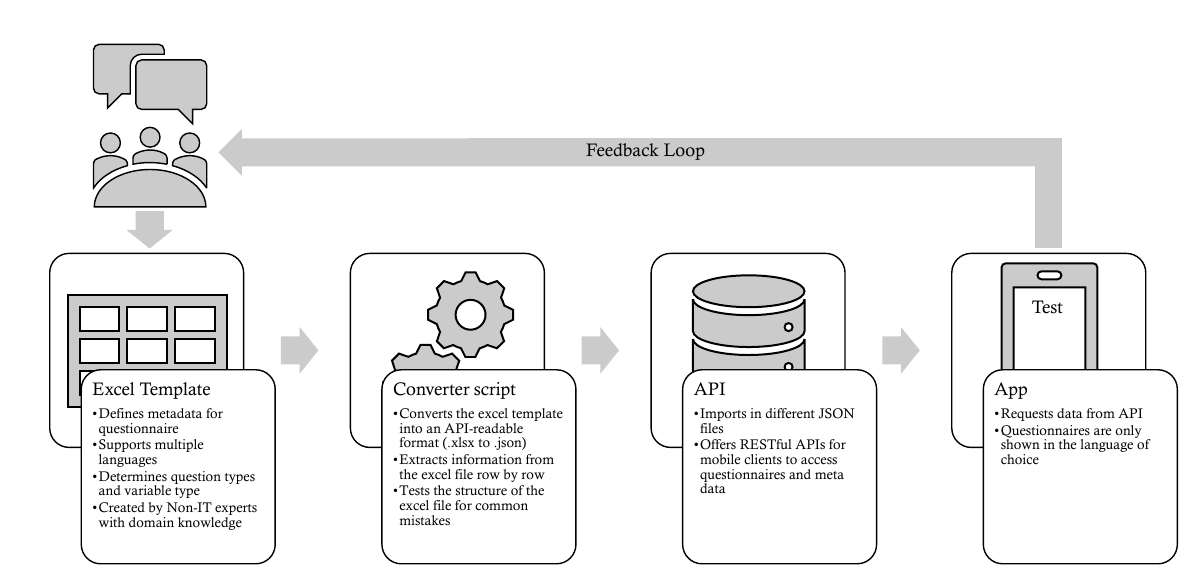
Figure 8. Steps to publish a questionnaire within the mobile application. The automated conversion allows for fast iteration cycles, resulting in a more flexible and end-user driven development